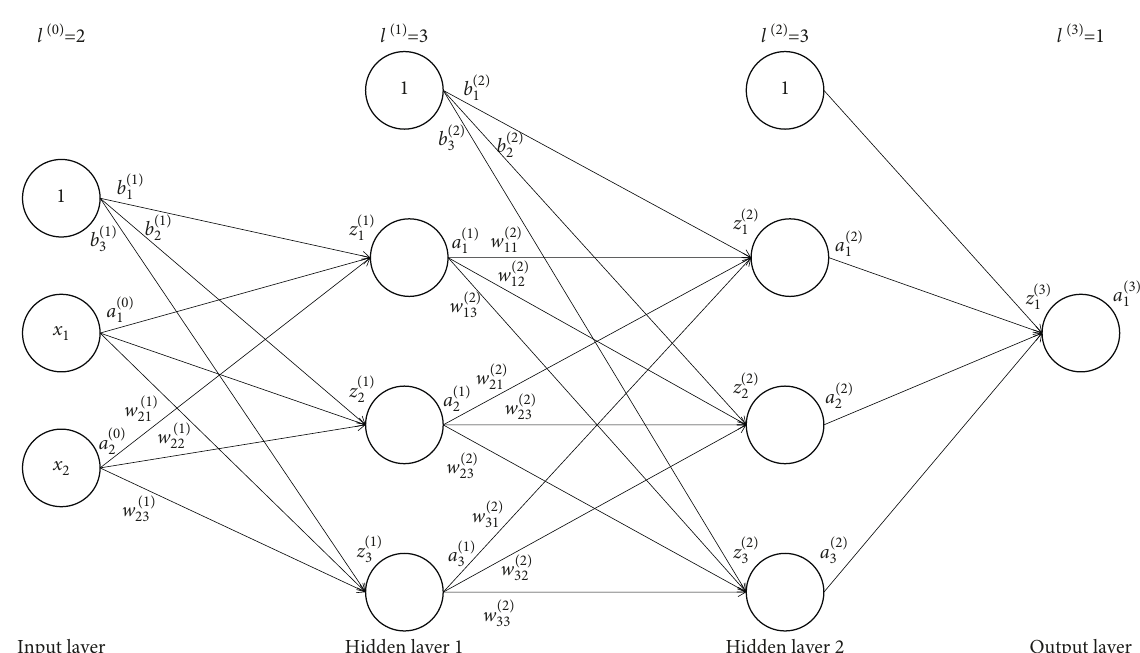
Figure 1: The neural network has the input layer and three layers (two hidden layers and the output